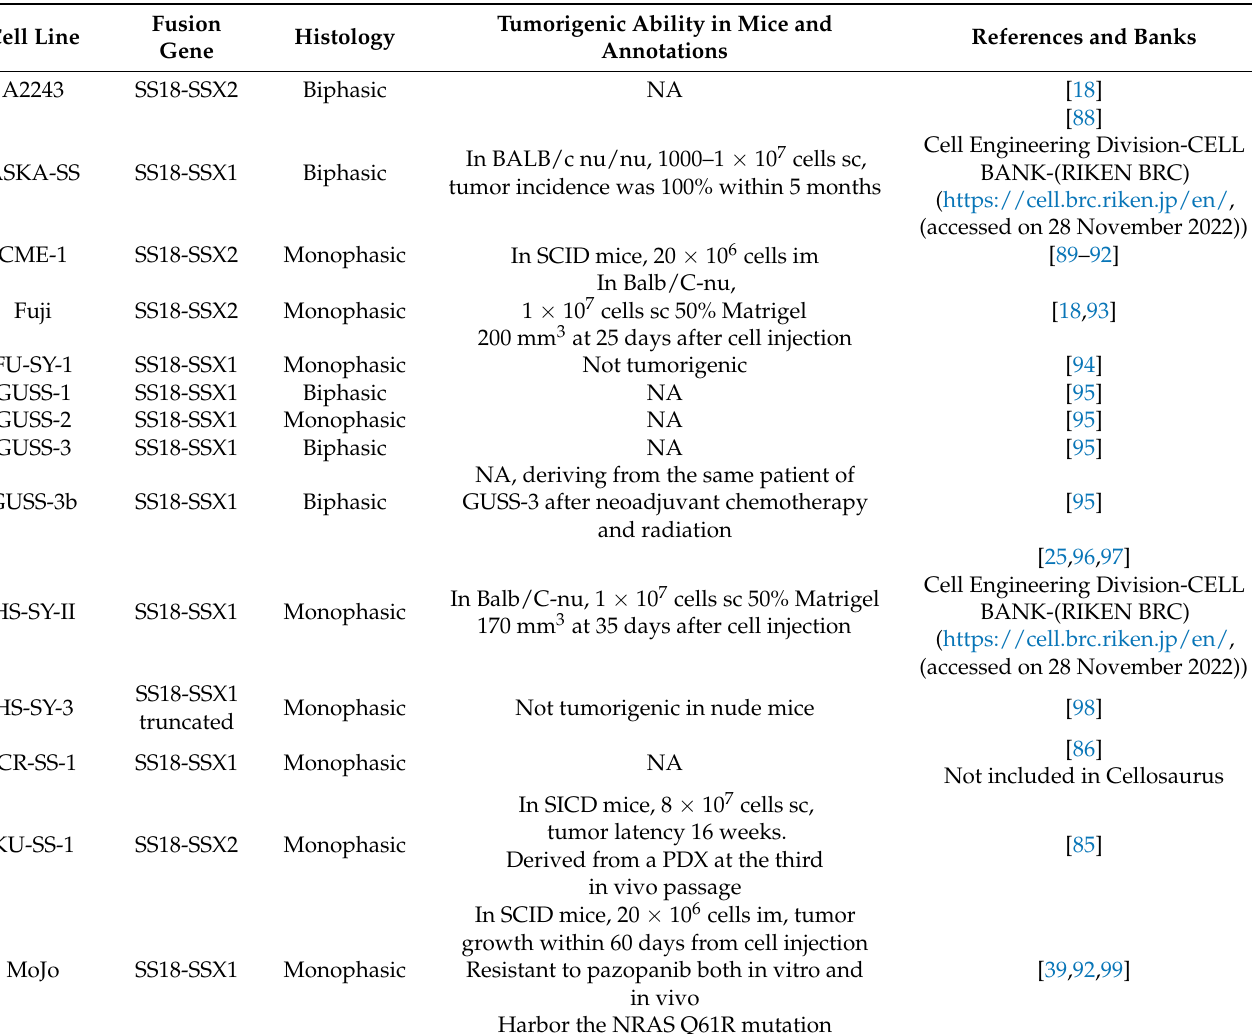
Table 6. Most used human SyS cell lines SS18-SSX translocated and CDX mouse